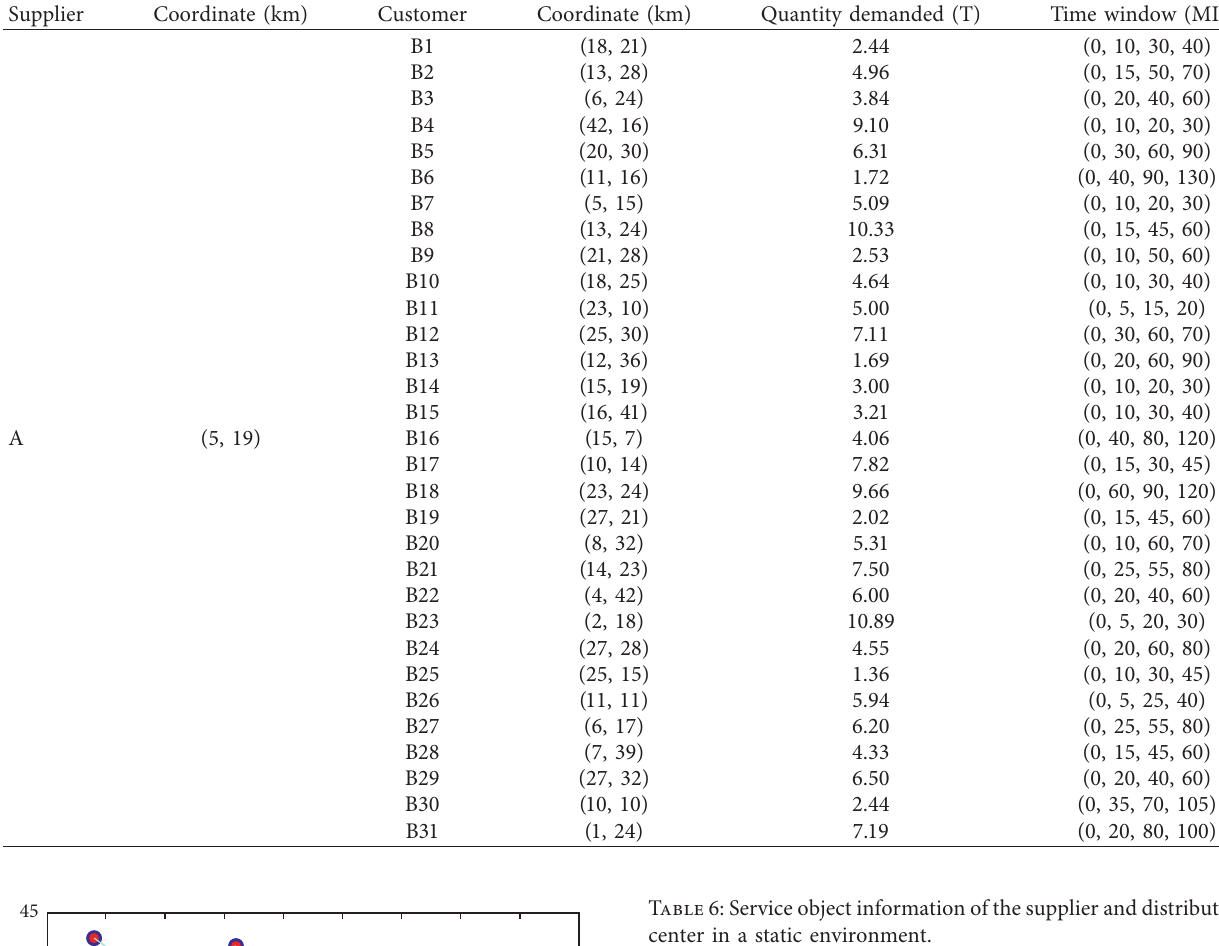
Table 4: Coordinate positions of suppliers and customers, quantity demanded, and time window.